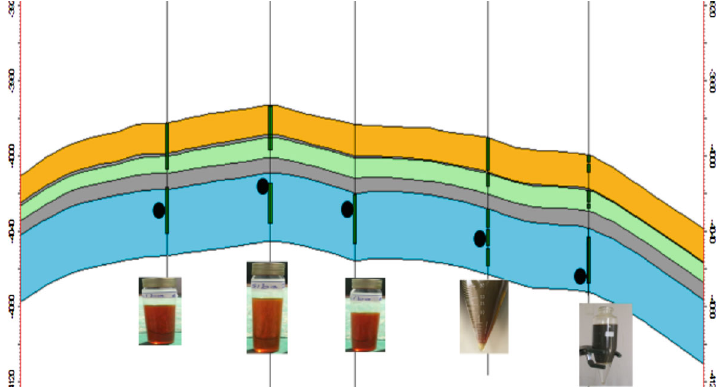
Figure 6: Sampling location of the original fl uid in S tight condensate gas reservoir.